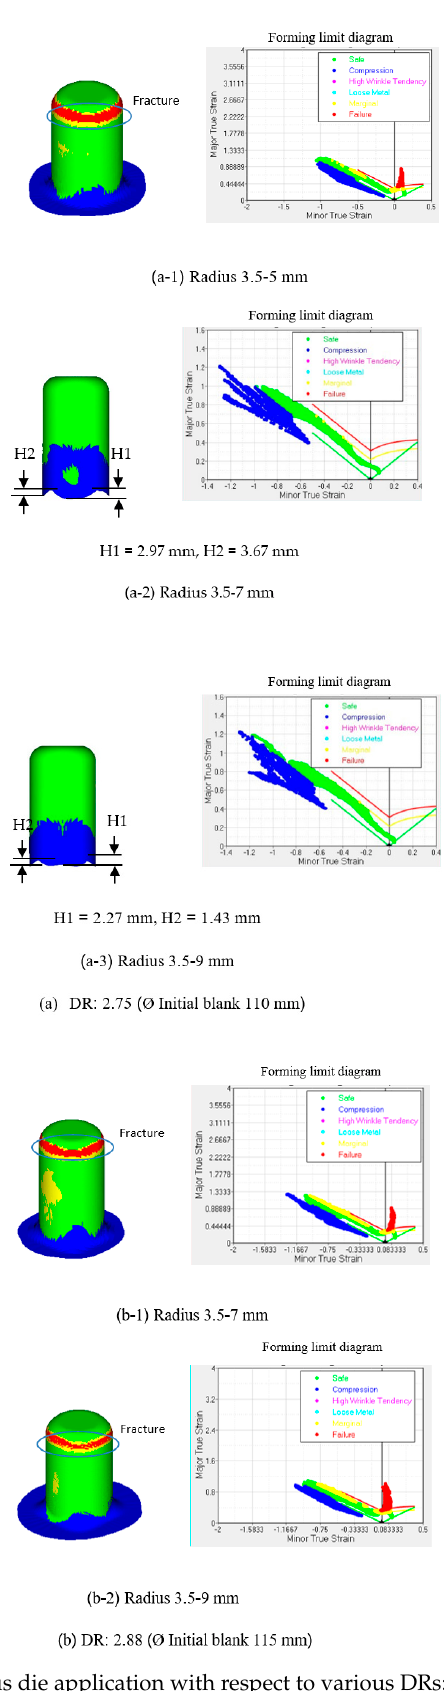
Figure 11. Multi draw radius die application with respect to various DRs: ( a ) DR: 2.75 (Ø Initial blank 110 mm); ( b ) DR: 2.88 (Ø Initial blank 115